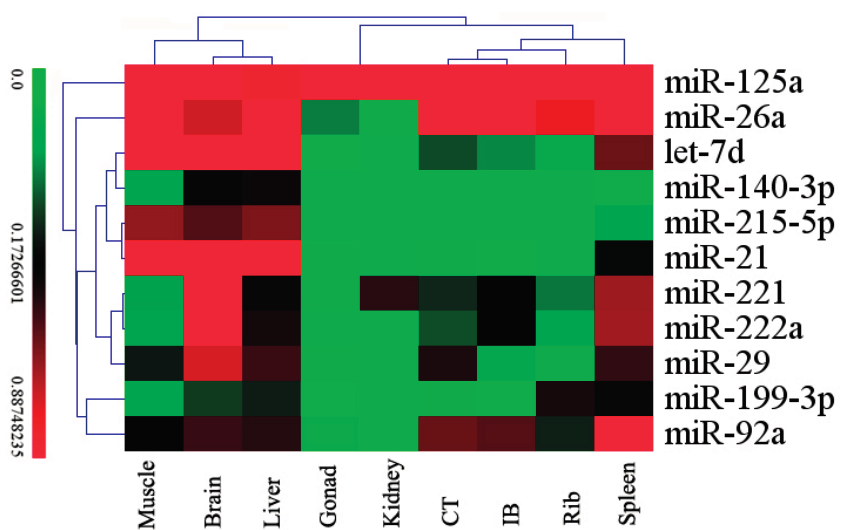
Figure 6. Heat map showing the 11 differentially-expressed miRNAs expression patterns in nine tissues measured by stem-loop RT-PCR. Relative expression levels of the 11 differentially-expressed miRNAs were measured in terms of threshold cycle value ( C t ) and were normalized to 5S rRNA. The expression data were analyzed by hierarchical clustering for both tissues and